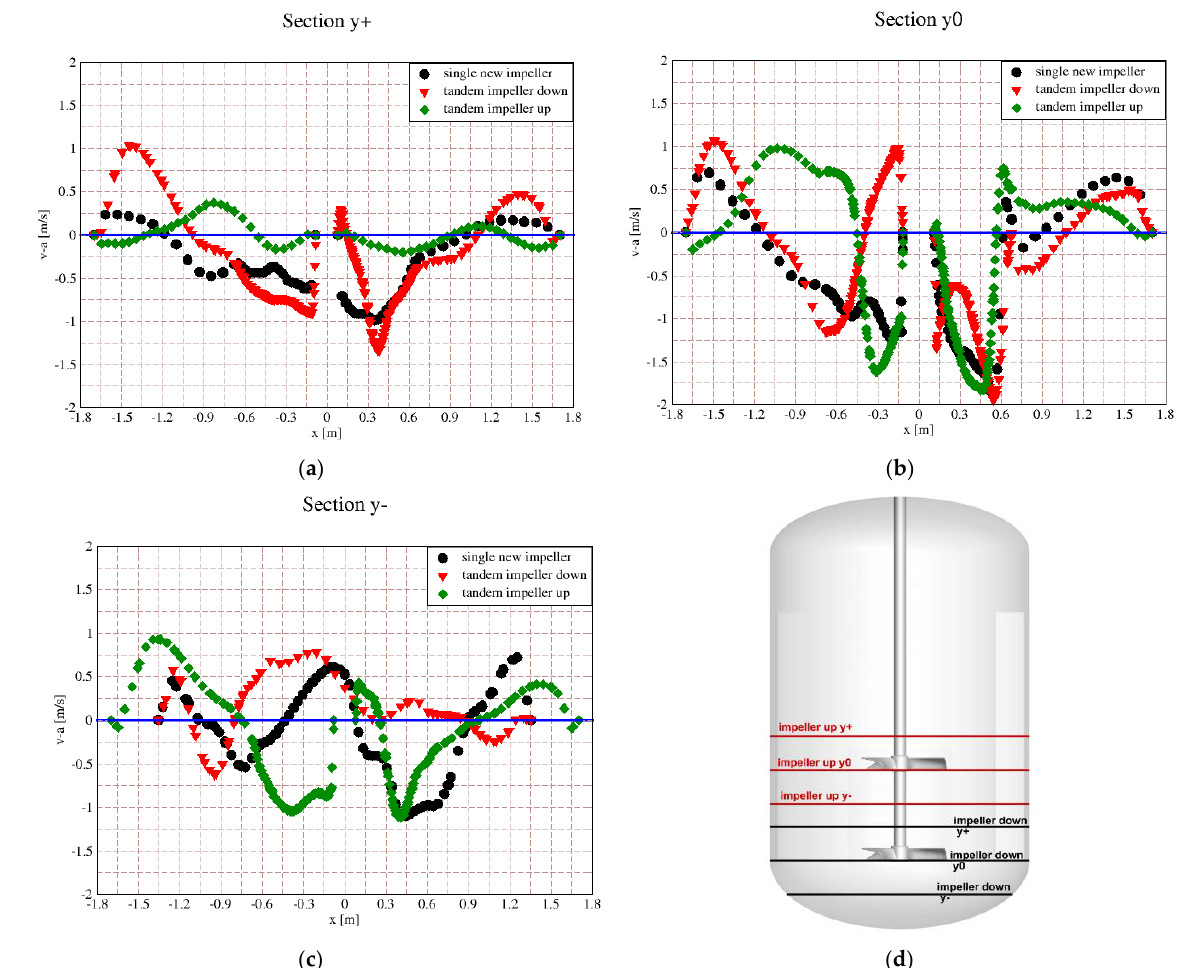
Figure 5. Axial velocity distribution of liquid phase at various axial levels, single new impeller vs. new impellers in tandem, instantaneous results: ( a ) above impeller; ( b ) impeller level; ( c ) under impeller; ( d ) axial levels position.